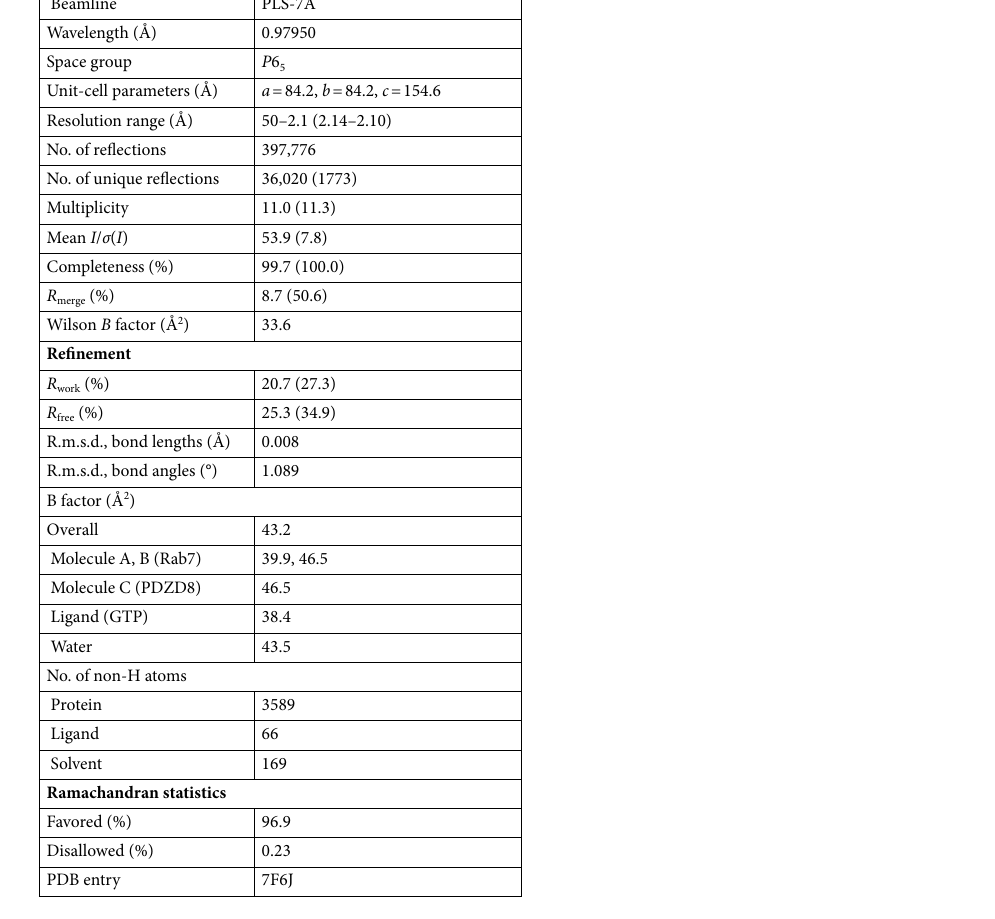
Table 1. Data-collection and refinement